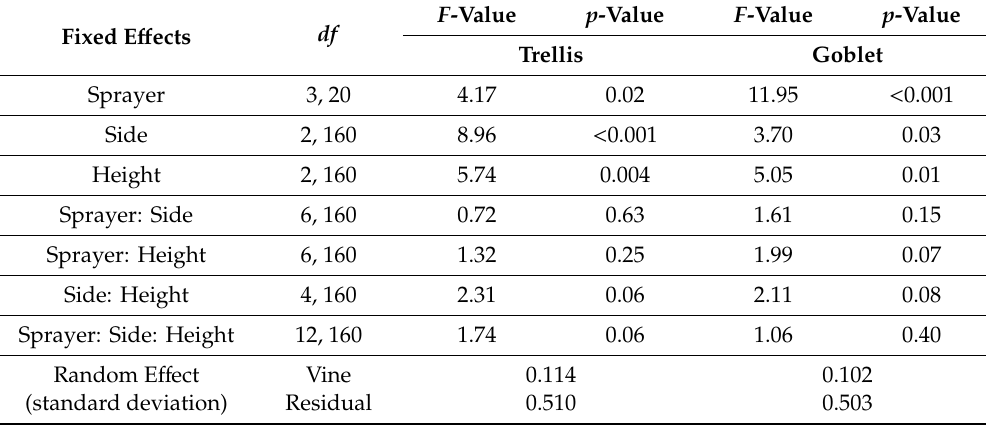
Table 4. The linear mixed-e ff ects model results for the e ff ect of sprayer, side and height on d G or d 100 on leaves for the trellis and goblet training systems. The analysis for d 100 is equivalent to that for d G as the two parameters di ff er only by a divisor of 2.5 (see Equations (3) and